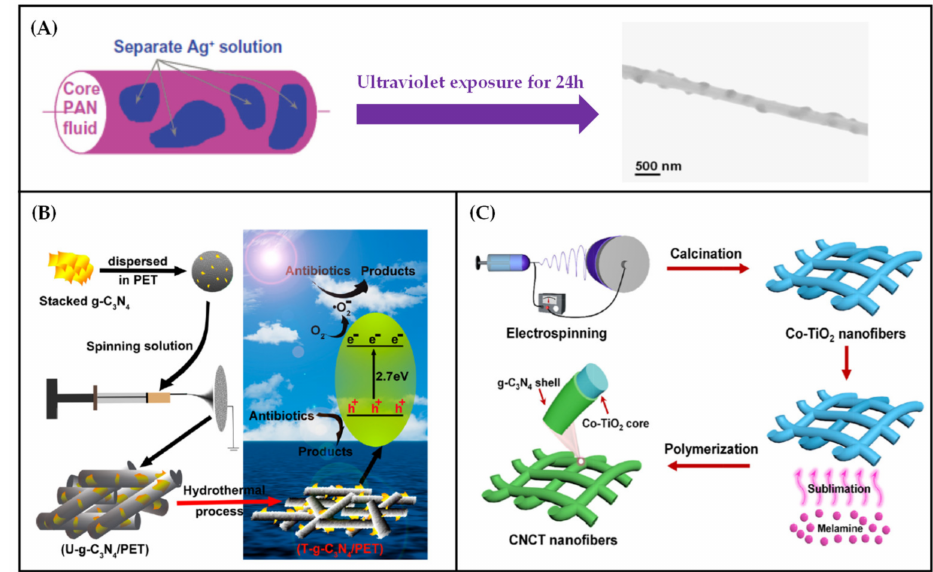
Figure 9. ( A ) The process of converting Ag + into Ag nanoparticles on the surface of PAN fiber by UV radiation [123]; ( B ) the preparation process of T-g-C 3 N 4 /PET nanofibers and the mechanism of degradation of antibiotics under solar irradiation [124] and ( C ) flow chart of preparation of soft CNCT nanofiber films